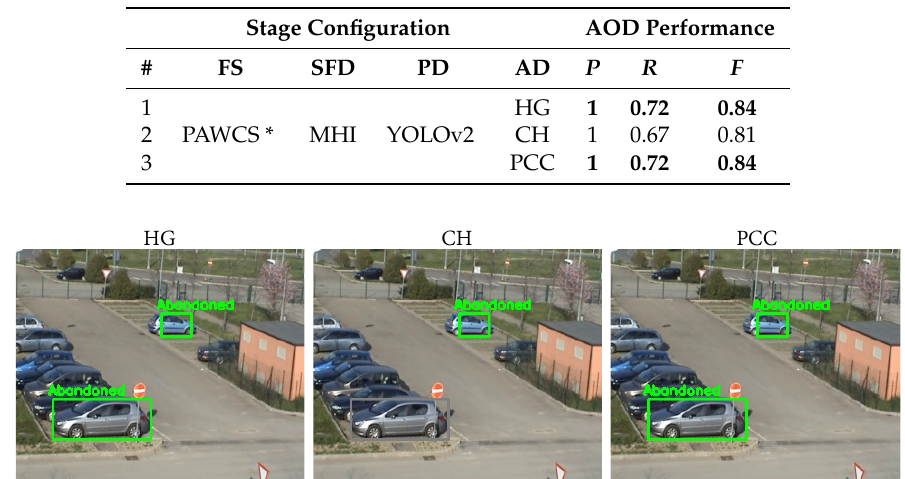
Table 9. Results comparing the approaches of abandoned discrimination for AOD performance. Bold indicates the best results. Key: FS = Foreground Segmentation. SFD = Stationary Foreground Detection. PD = Pedestrian Detection. AD = Abandoned Discrimination. P = Precision. R = Recall. F = F-score. CH = Color Histograms.